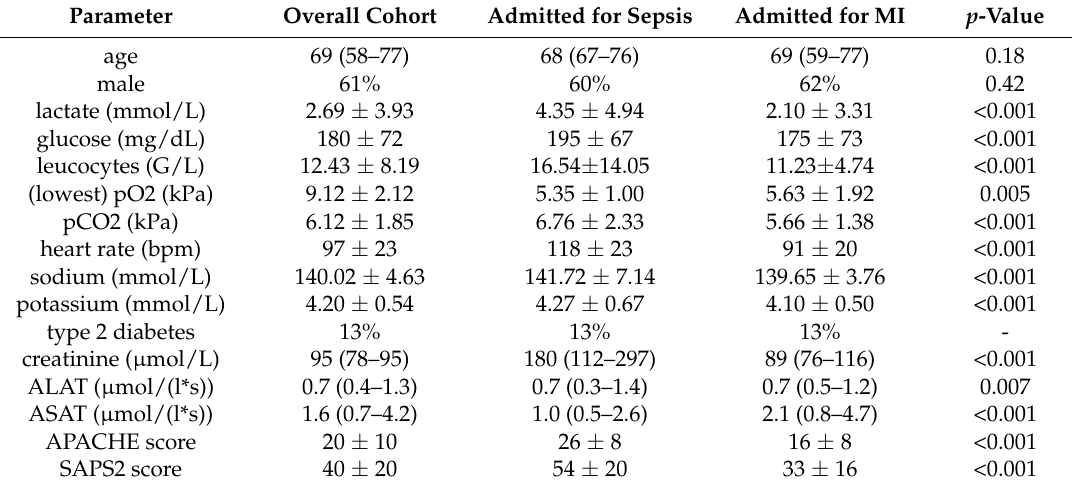
Table 1. Baseline characteristics of the overall cohort, patients admitted for sepsis and patients admitted for AMI.